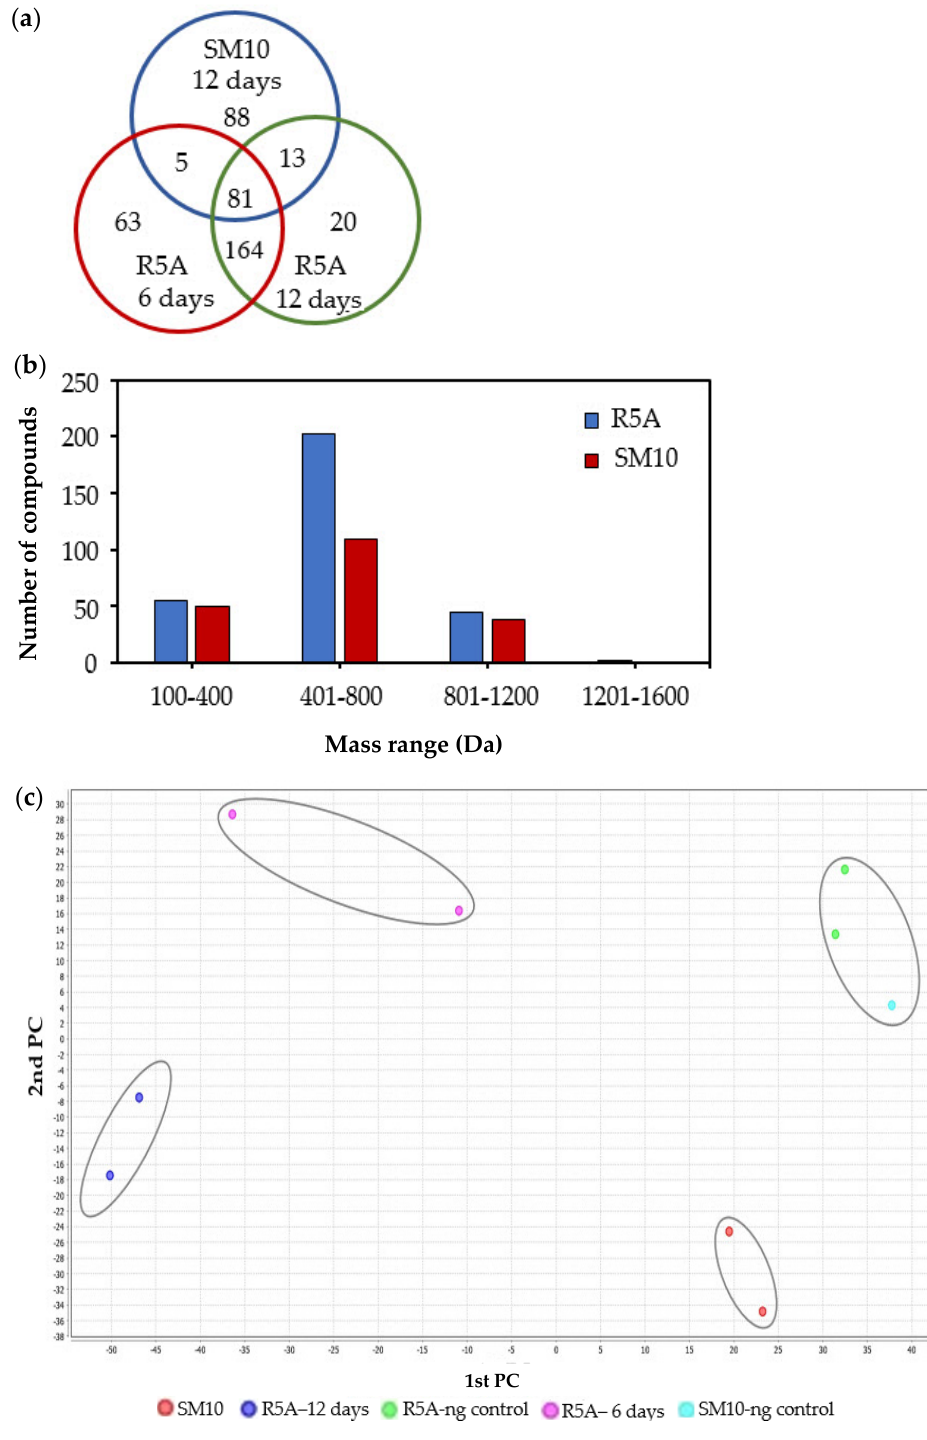
Figure 2. Metabolites of Streptomyces sp. SCSIO 001680: ( a ) unique and common metabolites after growth in R5A and SM10 media, ( b ) number of metabolites (masses) within mass ranges for each media, and ( c ) two-dimensional plot of metabolites produced in SM10 and R5A media by PCA